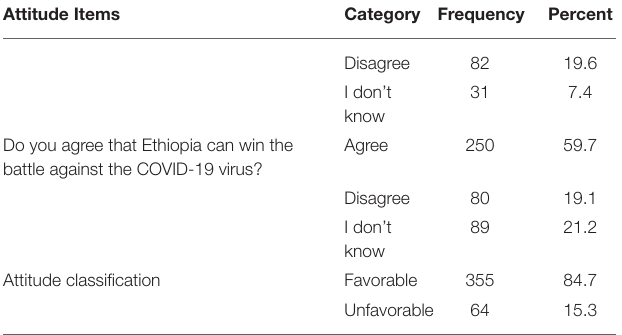
TABLE 4 | Health professionals’ practice on COVID-19 preventive measures in Dessie city, northeast Ethiopia ( N =